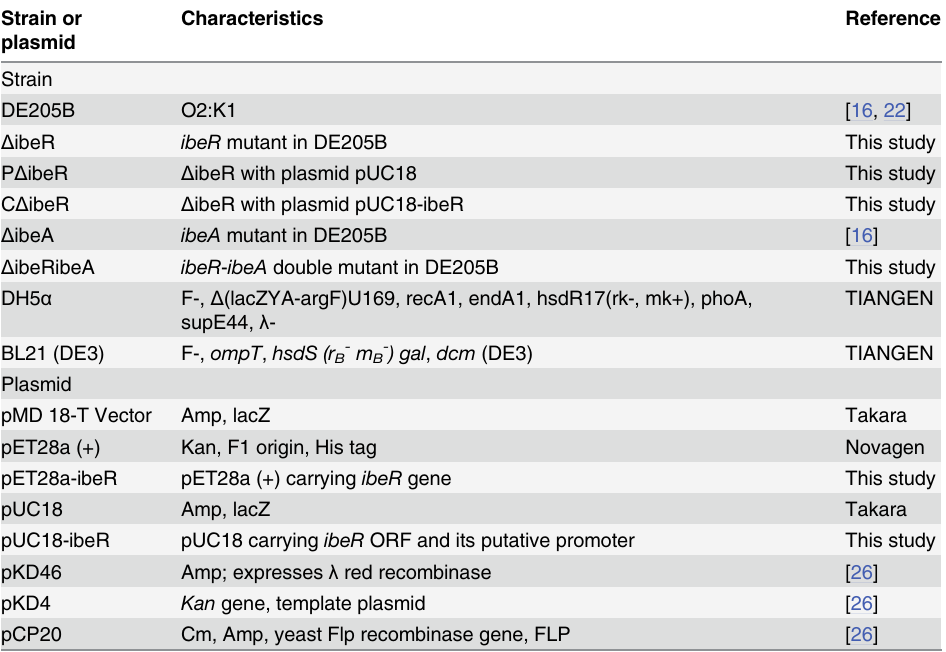
Table 1. Bacterial strains and plasmids used in this study. Strain or